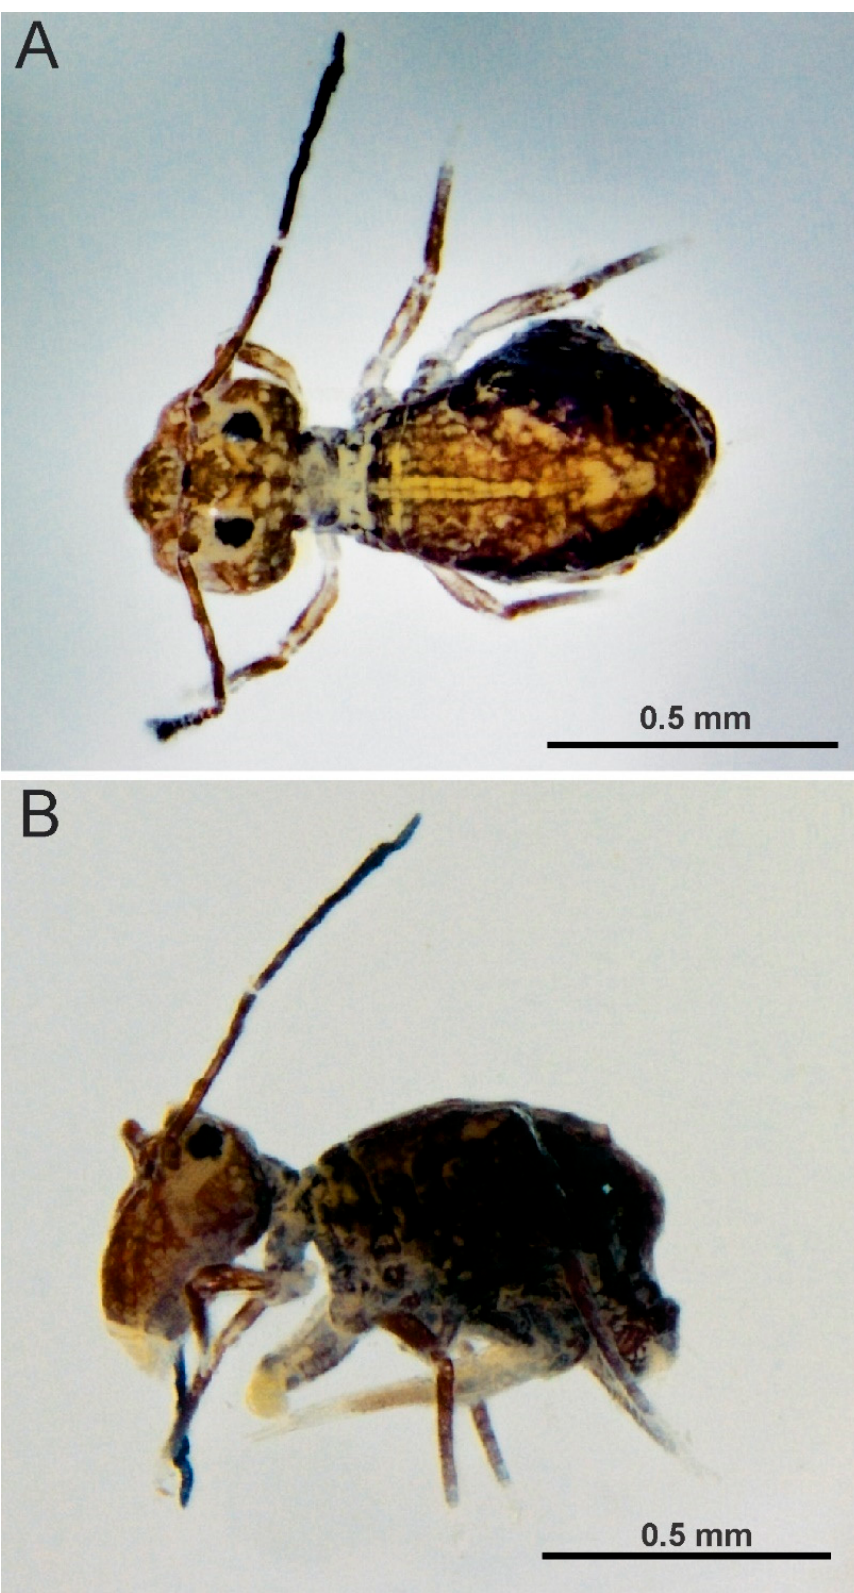
Figure 19. Calvatomina gladiata sp. nov. habitus in ethanol: ( A ) dorsal view; ( B ) lateral view.